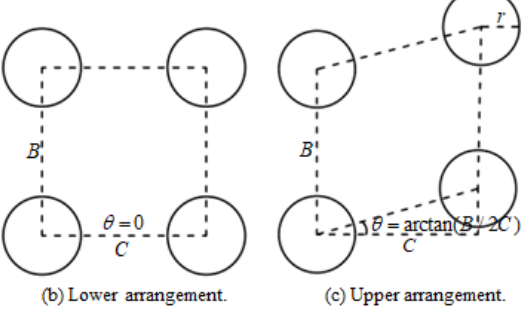
Figure 2. Schematic diagram of particle distribution.